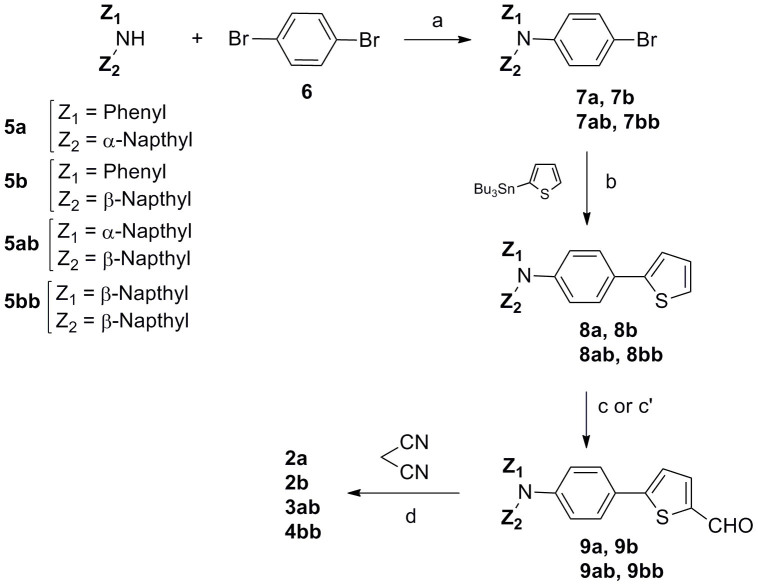
Synthesis of the target compounds.a) dpppPdCl2, t-BuONa, toluene, rflx 3 h; b) Pd(PPh3)4, toluene, rflx 16 h; c) 8a: POCl3, DMF, rflx 15 h; c') 8b, 8ab, 8bb, n-BuLi, DMF/THF, −78°C, 3 h; d) Et3N, CHCl3, rflx 7 h.